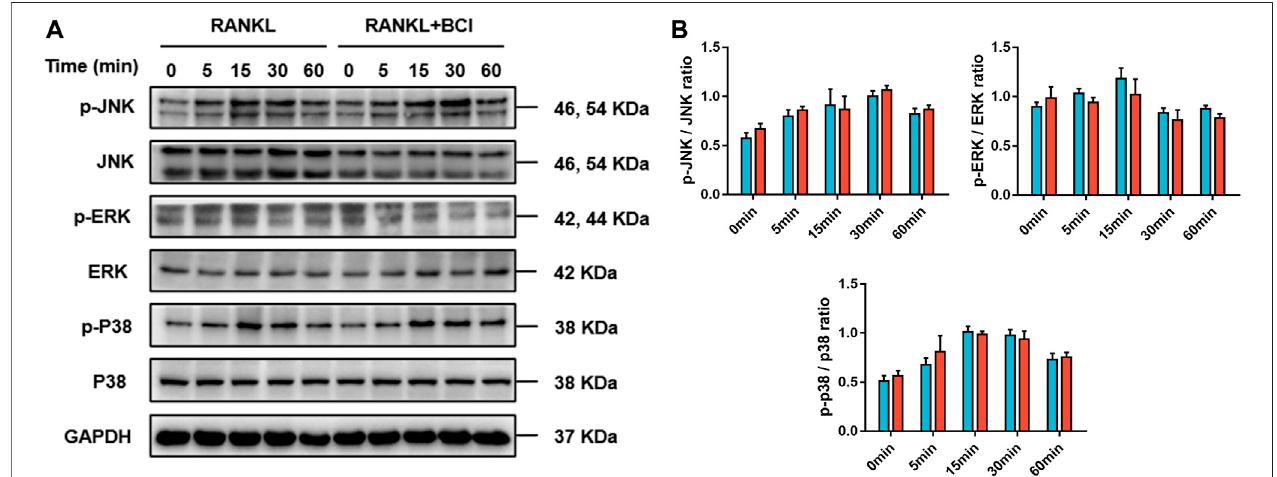
FIGURE 6 | BCI suppresses RANKL-induced osteoclastogenesis independent of MAPK signaling. (A,B) Western blot and corresponding quanti fi cation results showinglevelsofJNK,p-JNK,ERK,p-ERK,p38,andp-p38atvarioustimepoints(0,5,15,30,and60 min)inthecontrolandBCI-treatedgroups.GAPDHwasselected as the internal reference. * p < 0.05, ** p < 0.01, *** p < 0.001.